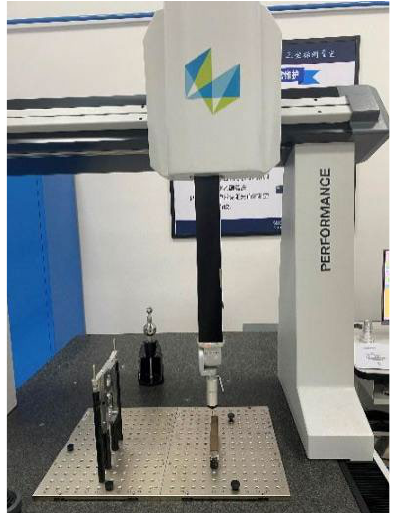
Figure 5. The three-coordinate measuring instrument diagram.